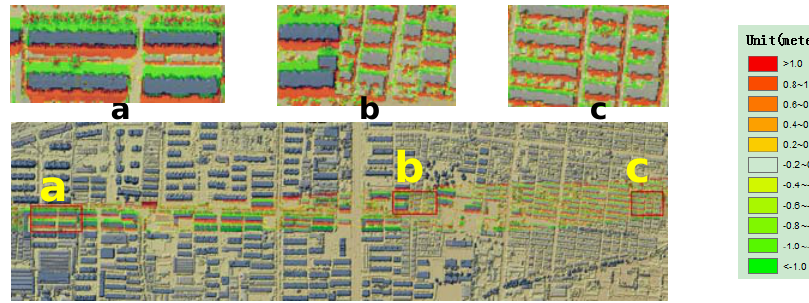
Fig. 8 Hypsometric layer map of overlapping region D-DSM